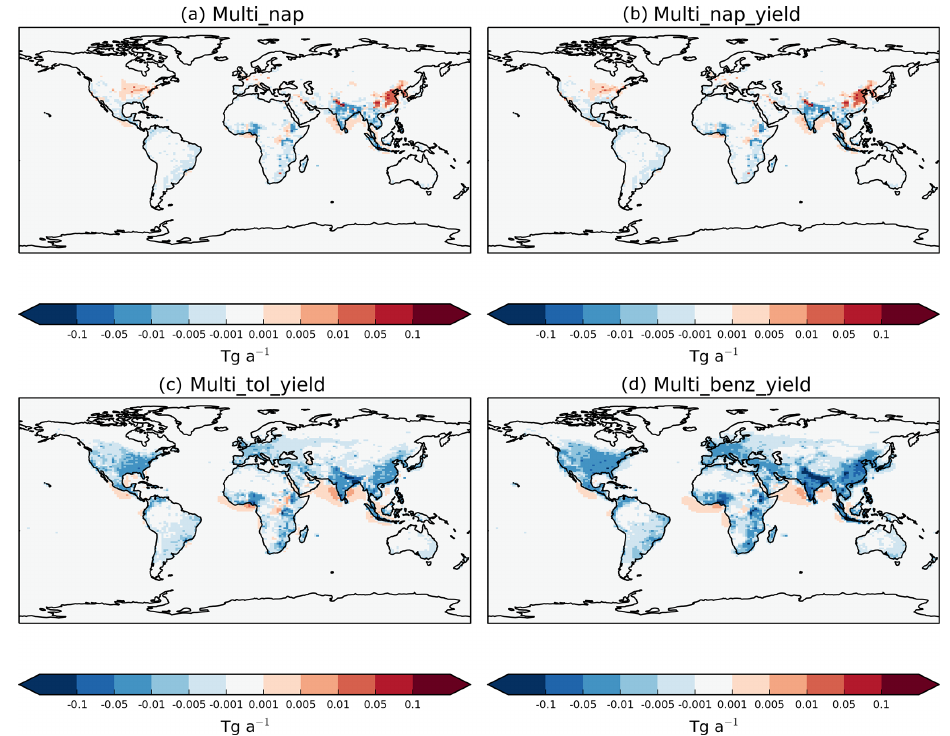
Figure 9. Global distribution of the absolute differences in annual-total vertically integrated VOC ANT / BB oxidation rates (Tg(VOC)a − 1 ) in (a) the Multi_nap, (b) the Multi_nap_yield, (c) the Multi_tol_yield, and (d) the Multi_benz_yield simulations relative to the DryH_WetL simulation.